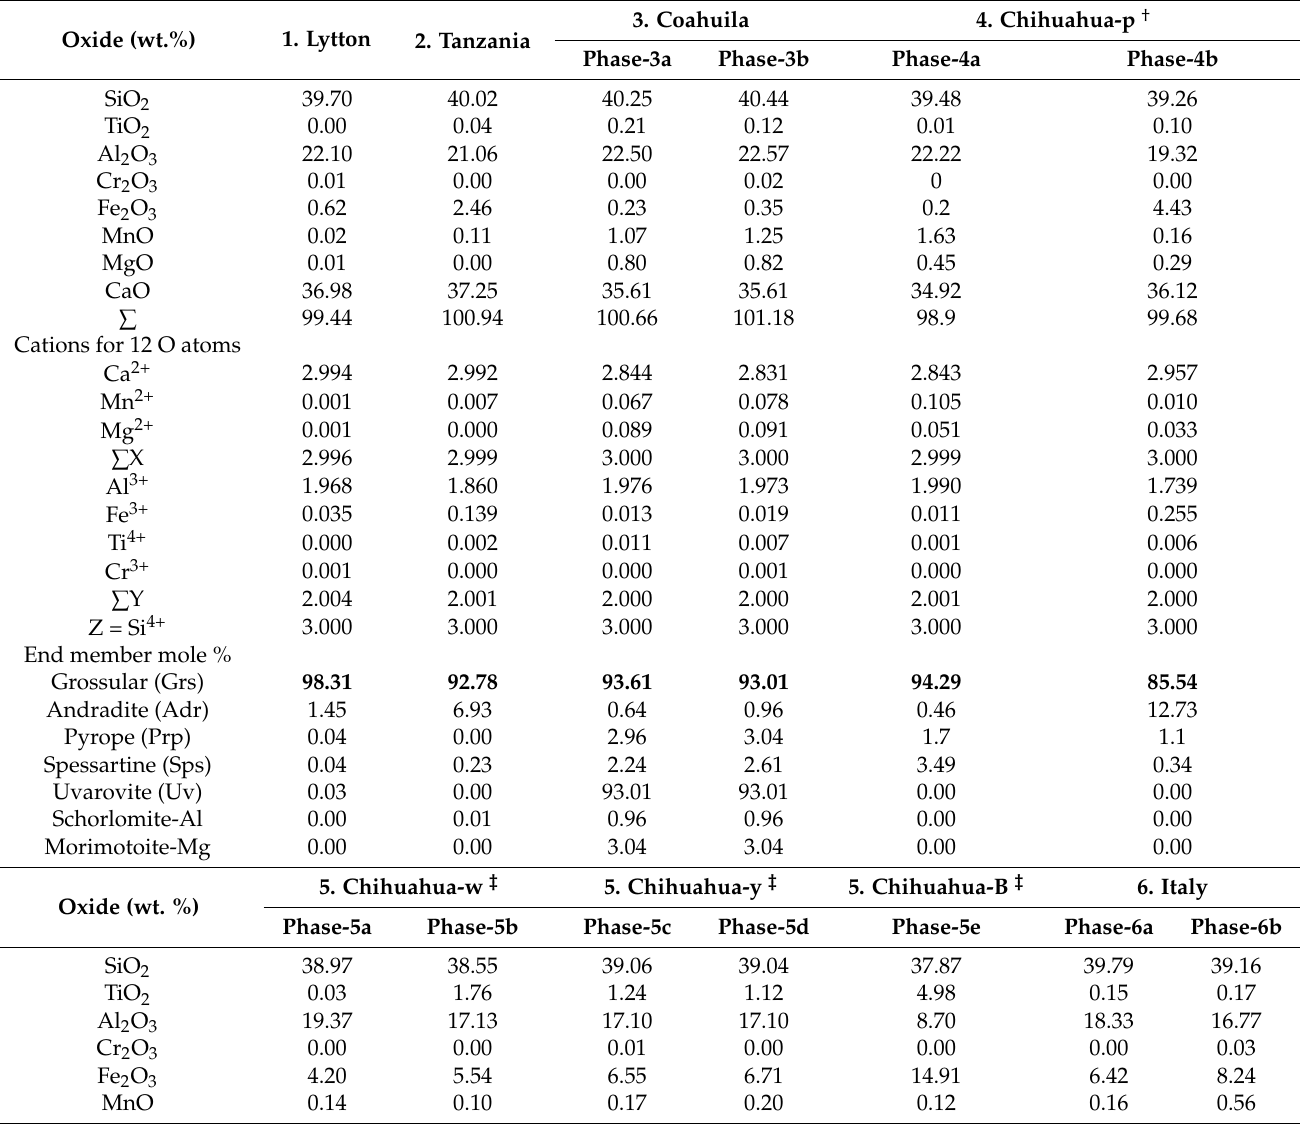
Table 1. EPMA results for six grossular